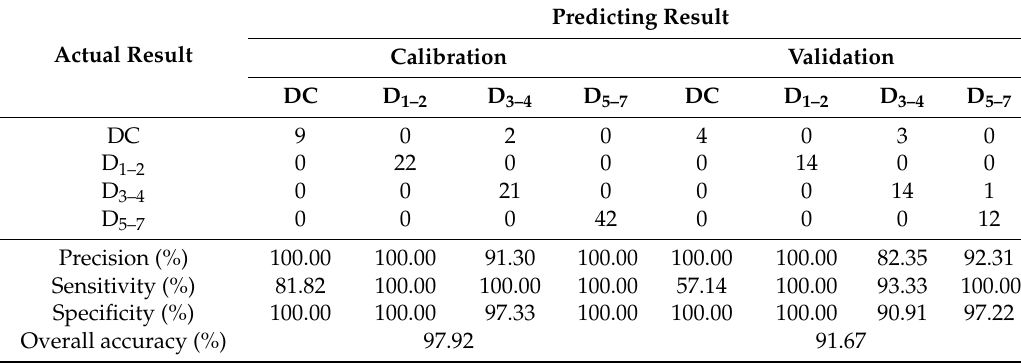
Table 2. Confusion matrix of calibration and validation set of the best model based on kernels orientated with germ up.